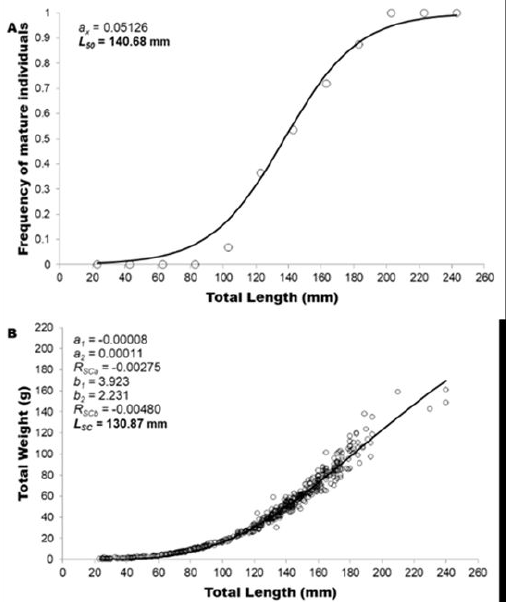
Figure 4. Proportion of mature (adult) by total length class (A) and Total length-total weight relationship ac- cording to Fontoura et al. (2010) (B) for P. managuensis at the Saco I dam, Serra Talhada-PE